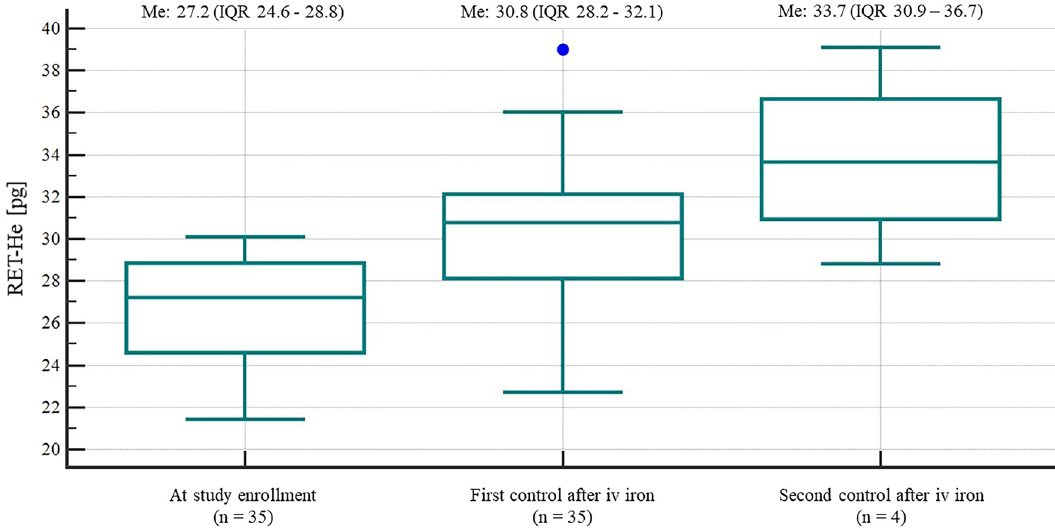
Figure 2. Reticulocyte hemoglobin equivalent at enrollment, on day 4 (first control) and 9 (second control) from the study enrollment.